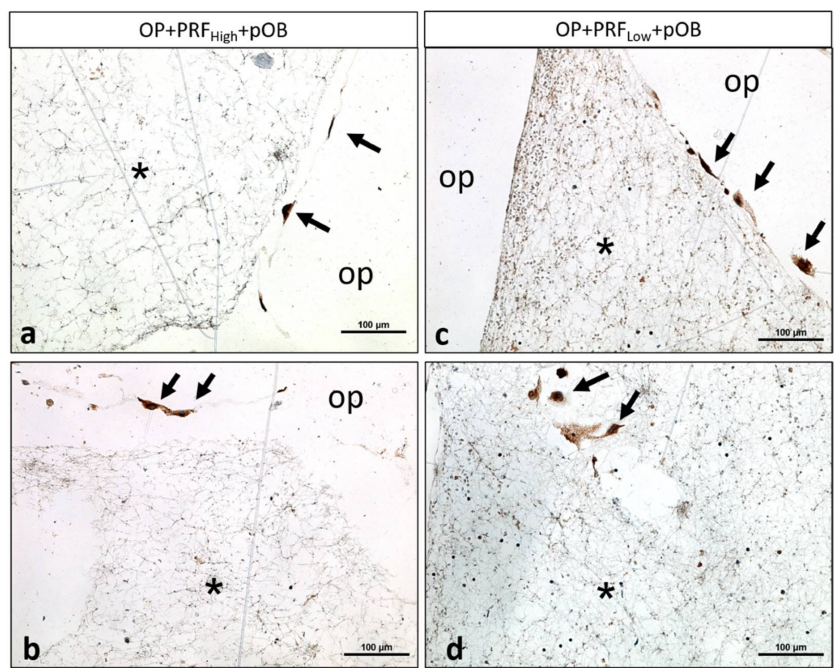
Figure 4. Immunohistological staining using Osteopontin shows the fibrin network (*) within the interspace of the biomate- rial (OP) in both groups after seven days. ( a , b ) illustrate the few osteoblasts (arrows) adherent at the OP-PRF high interface in the group of OP+PRF High +pOB compared to ( c ) the higher number of osteoblasts in the group of OP+PRF Low +pOB after seven days. ( d ) shows osteoblasts migrating into the fibrin network (*) that was formed within the biomaterial interspace in the group of OP+PRF Low +pOB.